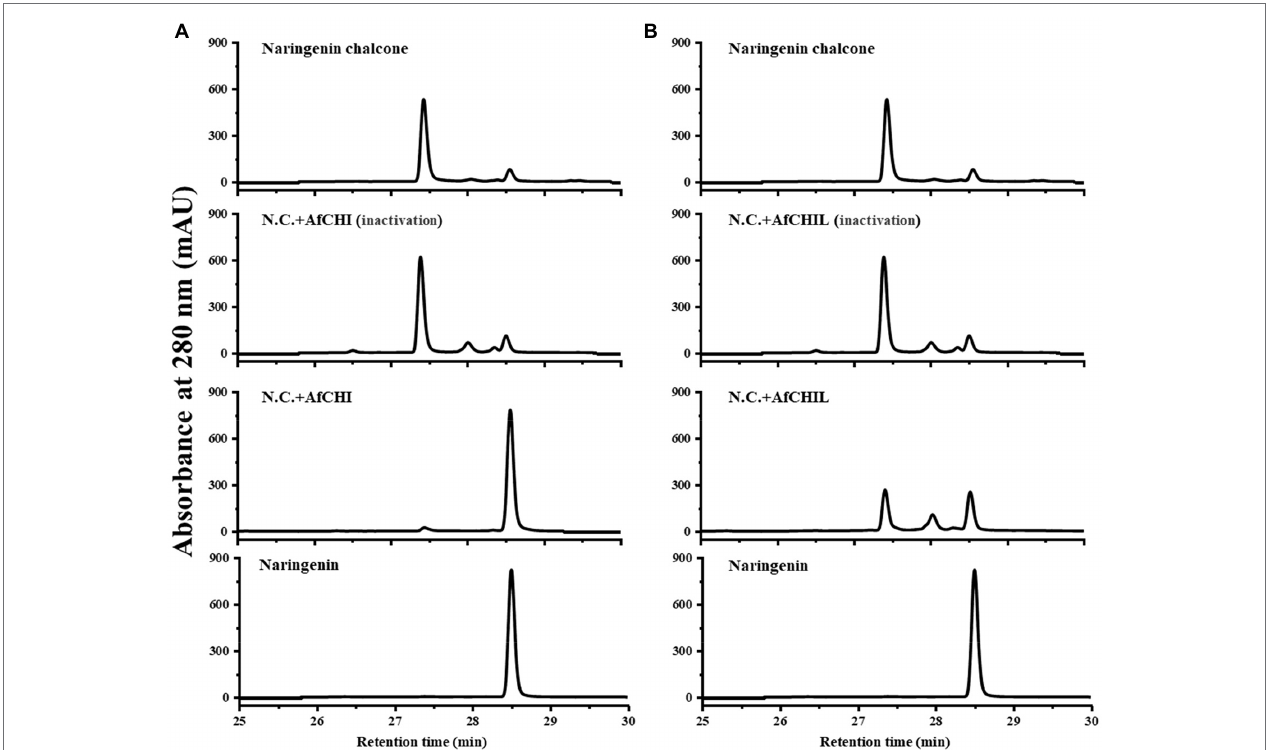
FIGURE 4 | In vitro enzymatic assays of the recombinant AfCHI and AfCHIL. (A) HPLC analyses of AfCHI reaction products. (B) HPLC analyses of AfCHIL reaction products. The assays were conducted with naringenin chalcone as substrate, and 10 μ g protein was added in each reaction. N.C., naringenin chalcone; N.A.,